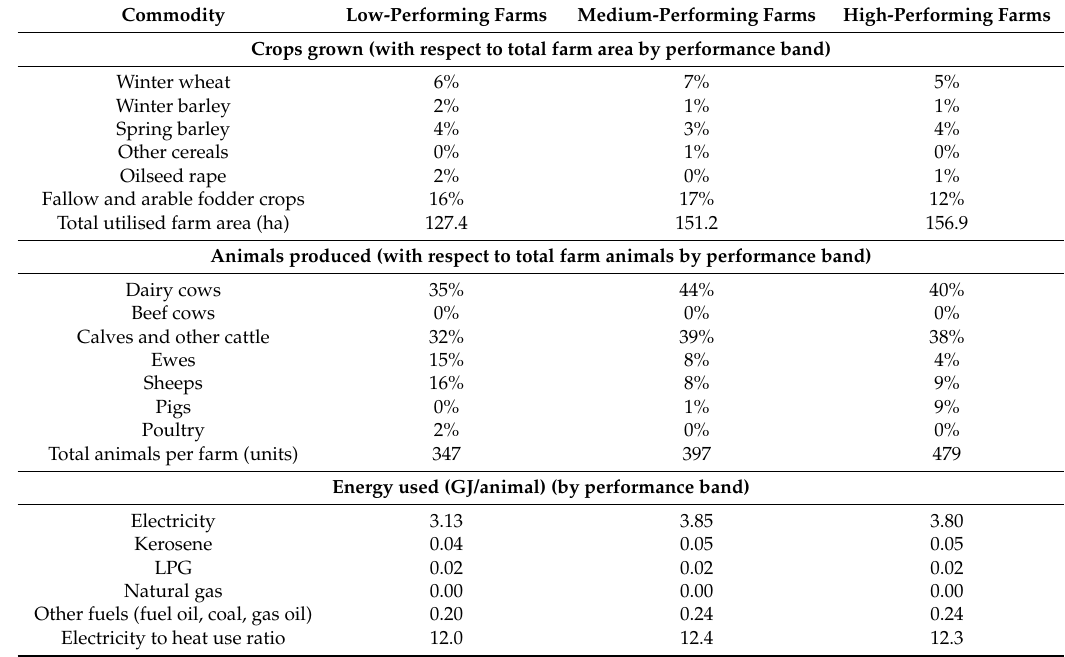
Table 3. Annual dairy farm input and output characteristics [27]. LPG: liquefied petroleum gas.